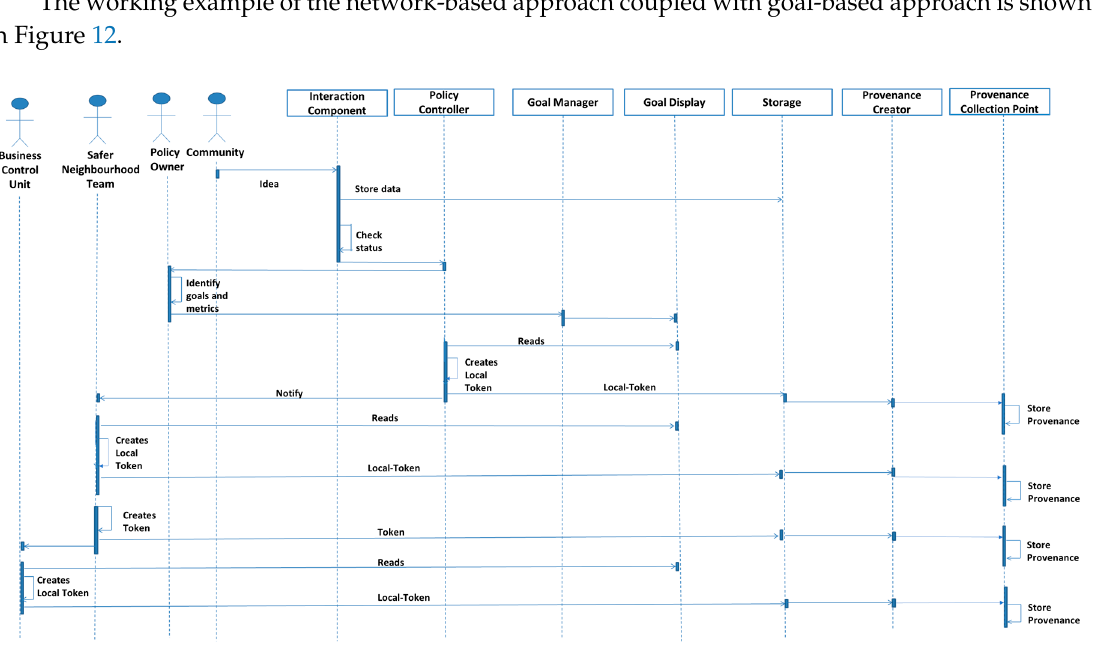
Figure 12. Working Example.